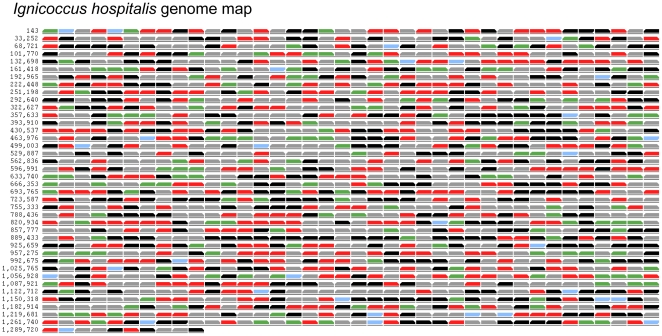
The I. hospitalis proteome and the effect of co-culture with N. equitans at the genome level.Genes are arranged in rows with the coordinates on the left corresponding to the nucleotide position in the genome. Blue indicate RNA genes. In black are genes encoding proteins that were not detected. Green and red correspond to proteins that were up- or down-regulated, respectively, by 1.5 fold or more between the co-culture versus the independent culture samples. Grey indicates proteins with <1.5 fold variation between the samples. The direction of the slanted rectangle indicates the direction of transcription. Not all consecutive genes transcribed in the same direction are predicted to be in the same transcriptional unit (operon).